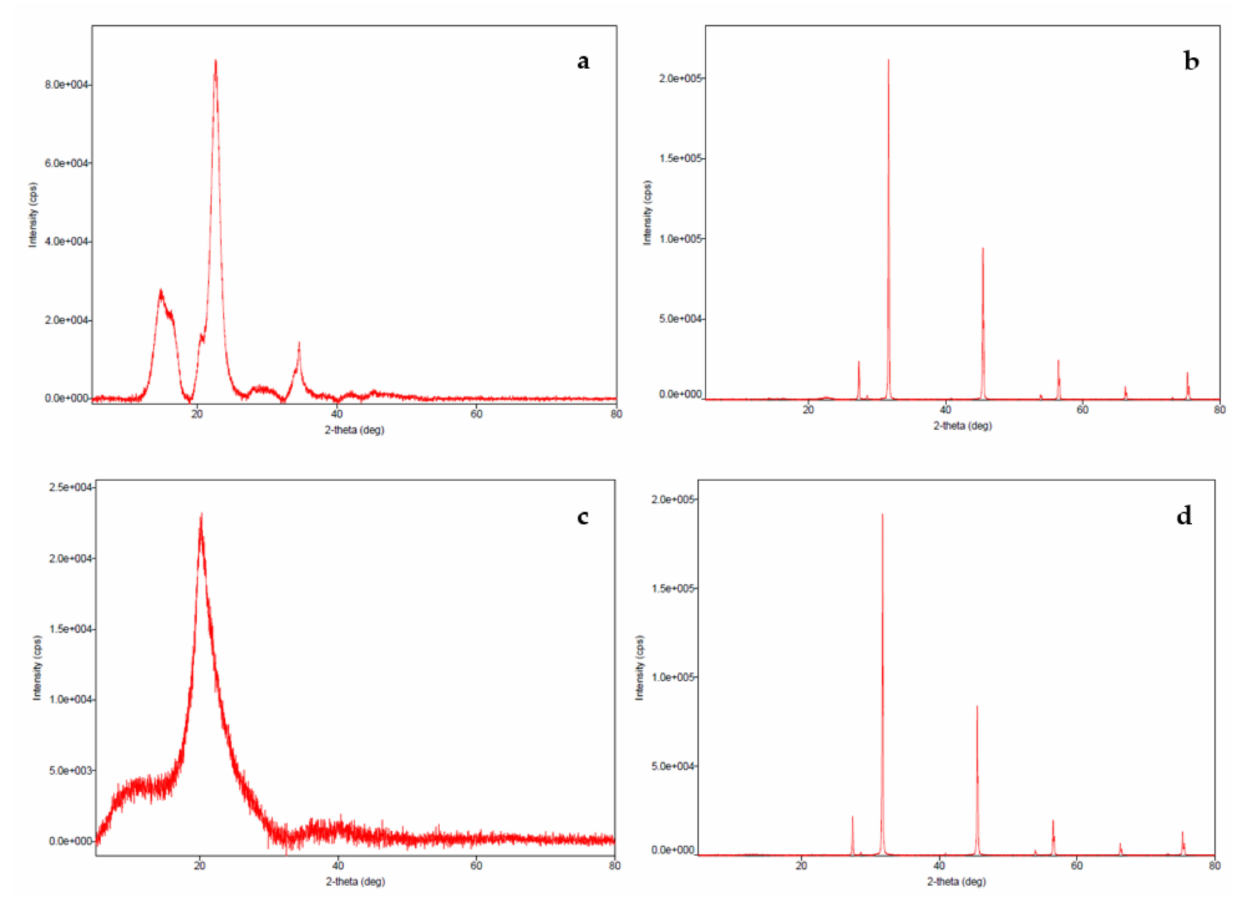
Figure 3. X-ray diffraction pattern of ( a ) MCC, ( b ) MCC-SiO 2 conjugates, ( c ) CMC and ( d ) CMC-SiO 2